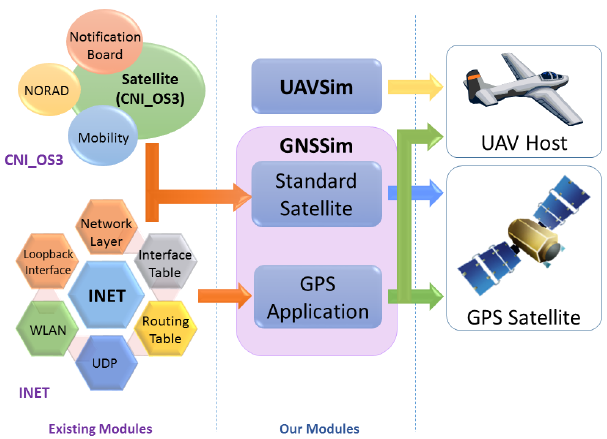
Figure 5. GNSS/GPS